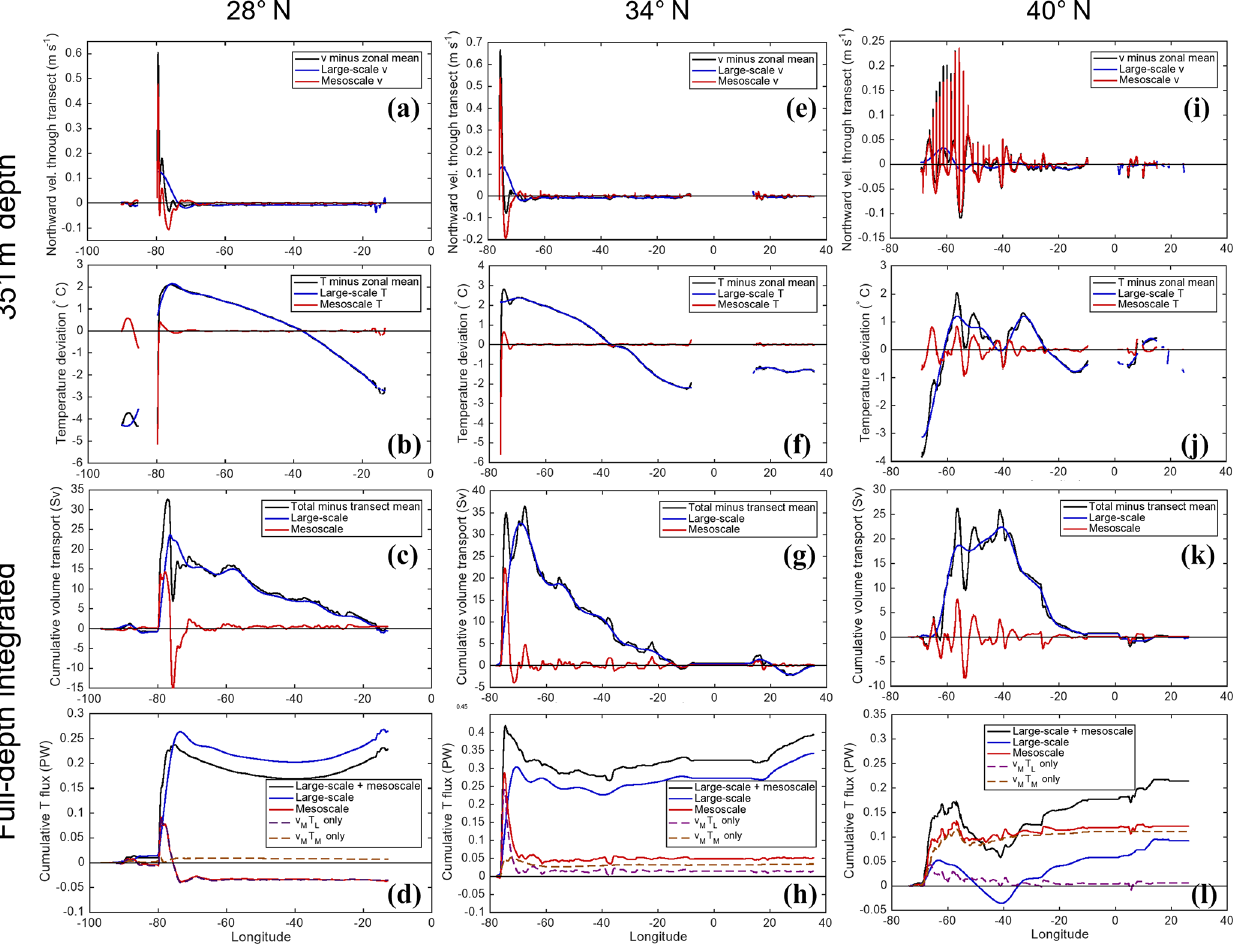
Figure 3. Structure of the time-mean velocity and temperature spatial decomposition at 351m depth for various latitudes, along with the full-depth cumulative zonally integrated volume transport and temperature flux. The left column shows the (a) northward velocity through the transect line and (b) temperature spatial decomposition at 351m depth for 28 ◦ N, along with the time-mean full-depth cumulative (c) volume transport and (d) non-overturning temperature flux. The center and right columns are the same but for latitudes (e) – (h) 34 ◦ N and (i) – (l) 40 ◦ N, respectively. In the upper panels, discontinuities in the curves indicate land